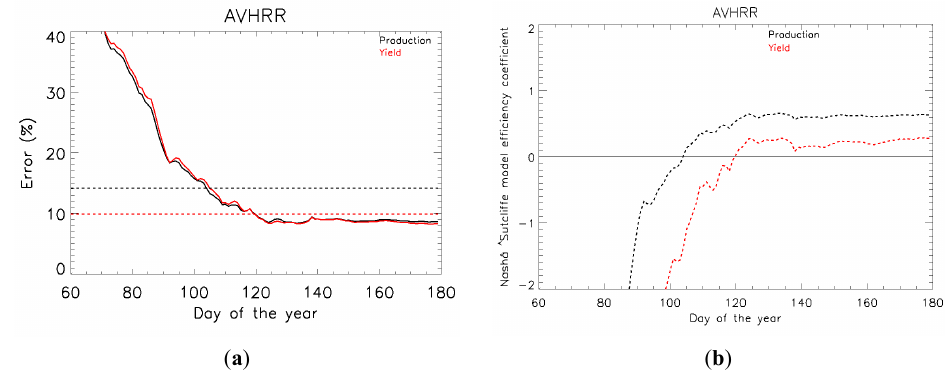
Figure 10. ( a ) Percentage error evolution when forecasting the winter wheat production (black) and yield (red) with historical AVHRR data. The dashed line represents the error committed when considering a constant production (black) or yield (red) and equal to the average through the time series; and ( b ) Nash–Sutcliffe model efficiency coefficient evolution depending on the day of the year of the forecast.